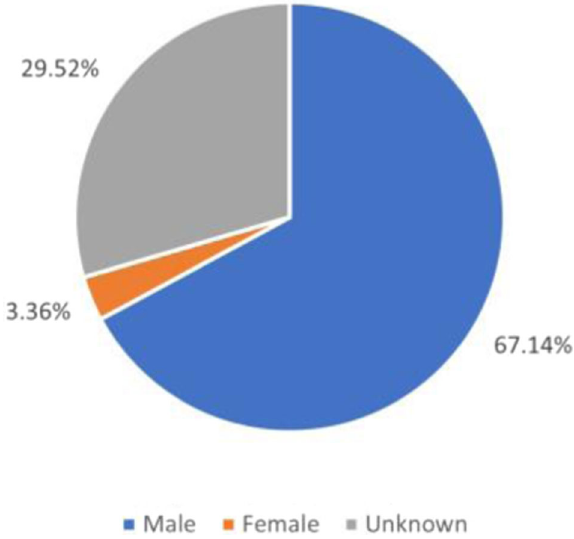
Fig. 2 Gender distribution of mid-17th century token issuers in London. This chart details the distribution of token issuers according to gender, which was determined based on the issuers ’ names. The tokens that fall under the category “ unknown ” include tokens that have no inscription of a name; tokens that are inscribed only with a name of a business; and tokens inscribed with initials and no full name of an issuer, the largest group of unknown issuers. In addition, a very small number of tokens had abbreviations of names or names for which the gender was unclear (see Fig. 3).